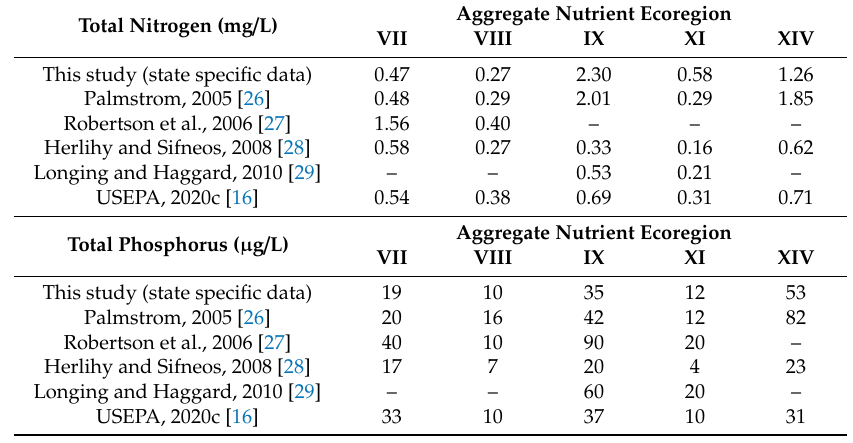
Table 2. Total nitrogen and total phosphorus 25th percentile concentration values for USEPA’s aggregate nutrient ecoregions of Pennsylvania, from this study compared to other published